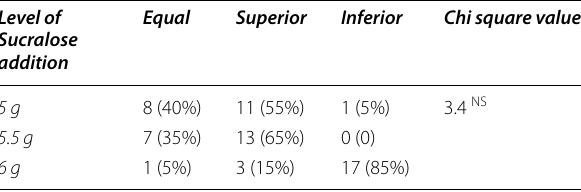
Table 6 Difference test for varying levels of sucralose addition in 100% GOS gummies